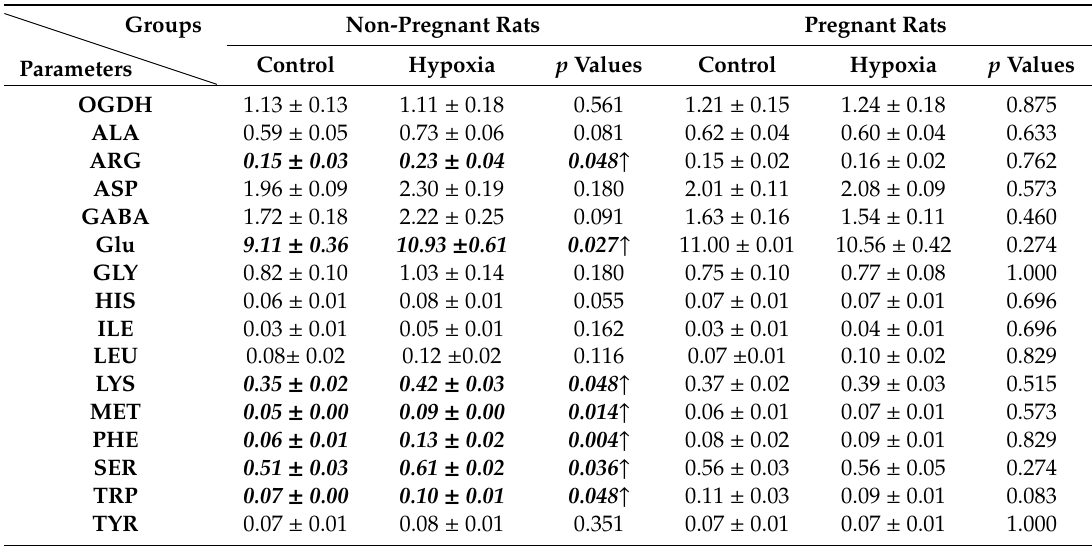
Table 2. Influence of acute hypobaric hypoxia on the OGDHC activity and amino acid pool in cerebella of the non-pregnant and pregnant